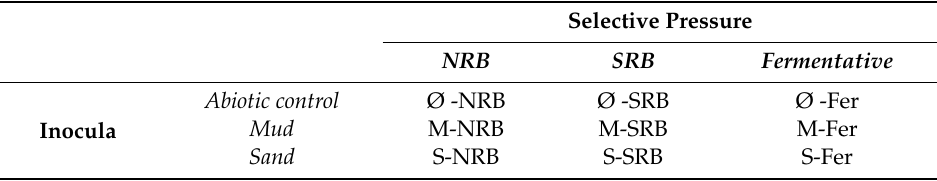
Table 3. Selective cultures of estuarine sediments in relation to sediment type and selective pressure (in italics) for certain anaerobic metabolic types. NRB—nitrate reducing bacteria; SRB—sulfate reducing bacteria; Fer—fermentative bacteria.